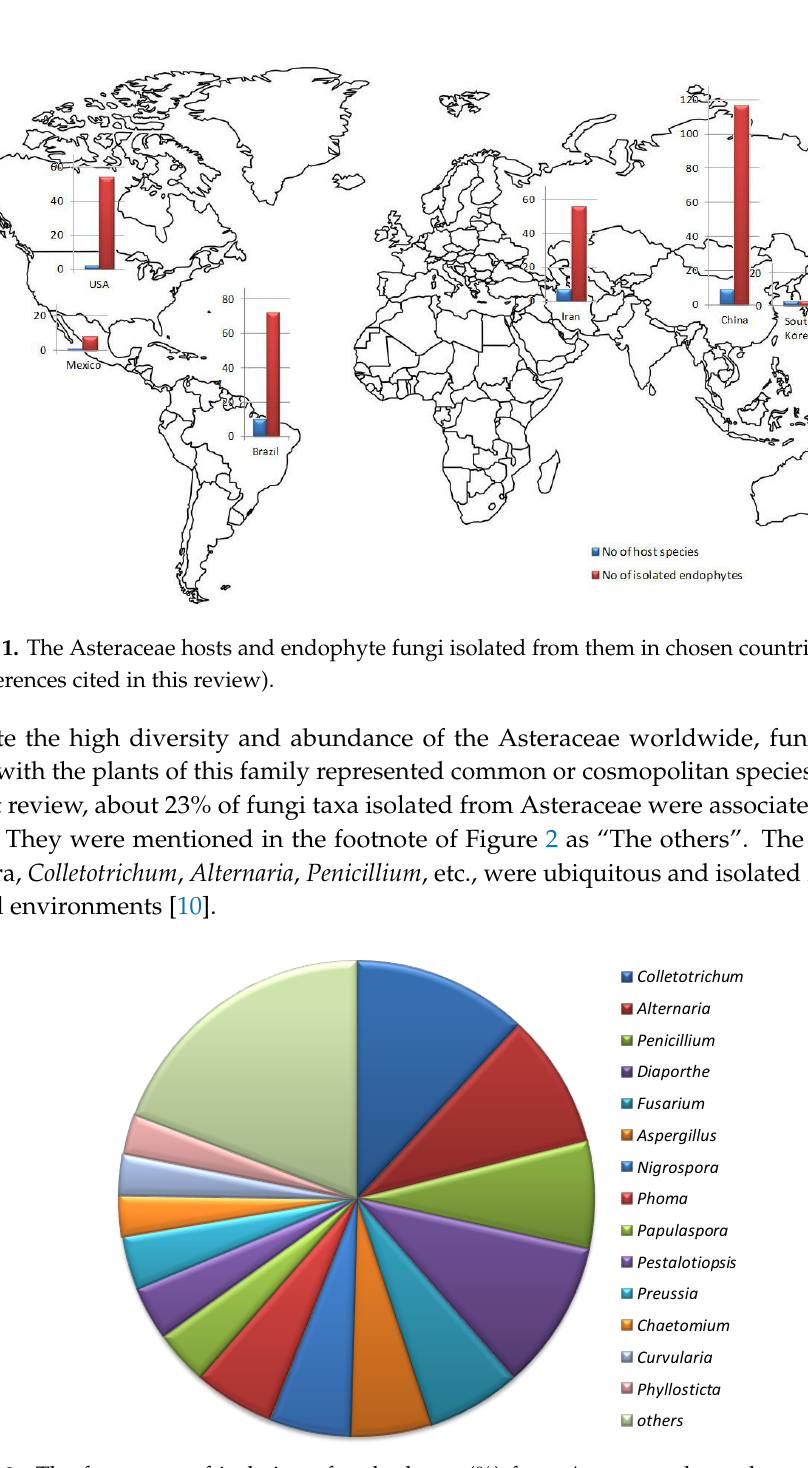
(synonym of Neja marginata ), Erigeron bellidiastroides , Erigeron cuneifolius , Pectis juniperina , and